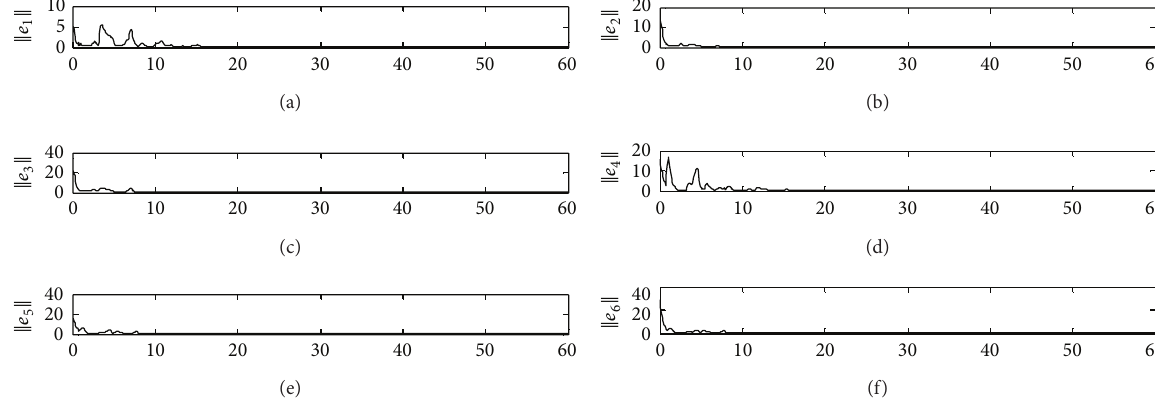
Figure 1: Synchronization errors of BDN (55) and (57) with adaptive feedback controllers (20).